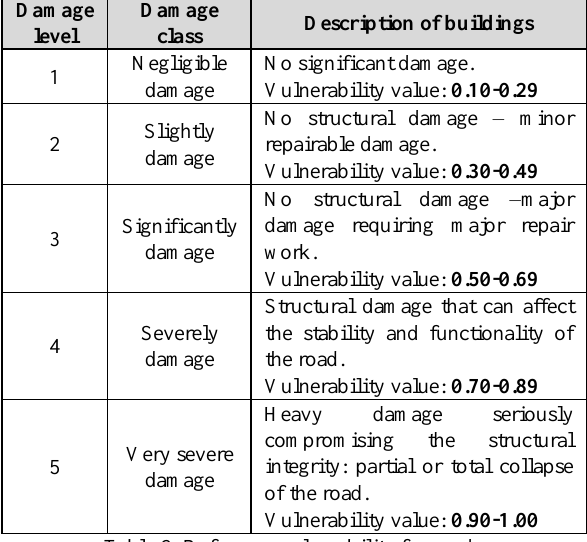
Table 2. Reference vulnerability for roads